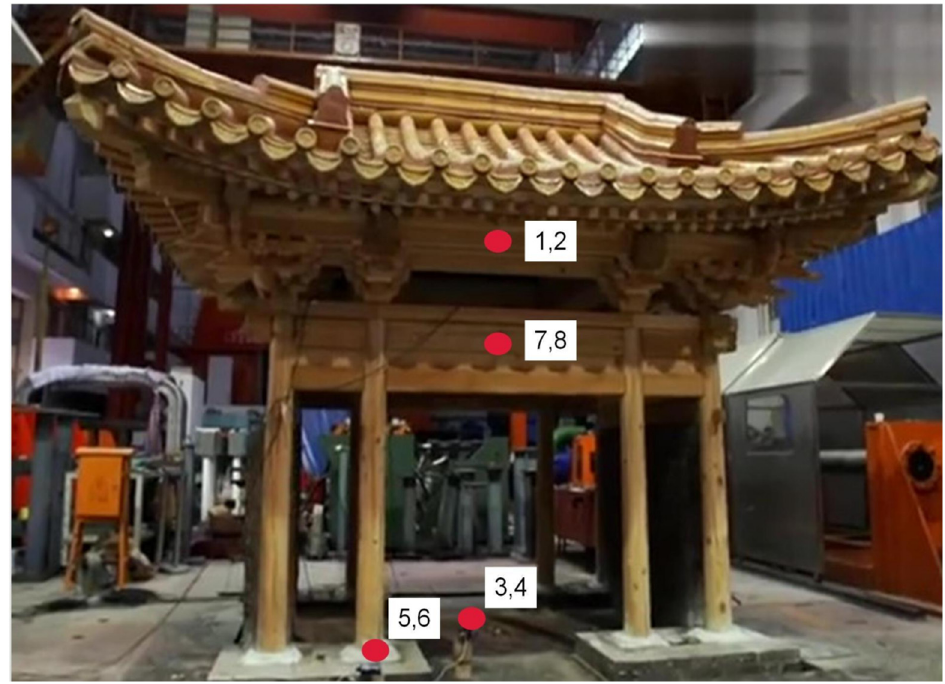
Figure 11. A 1:5 scale model of Shoukang Palace earthquake test map.